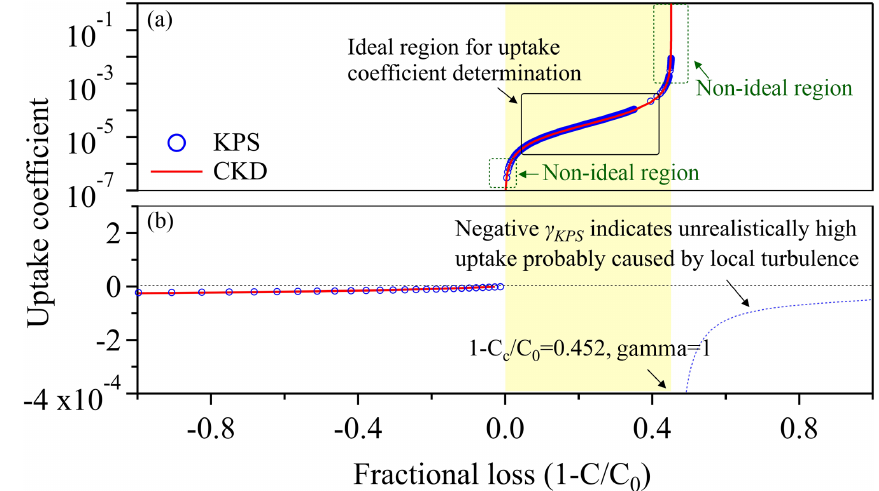
Figure C1. Comparisons between uptake coefficients (derived from KPS and CKD methods, respectively) versus the fractional loss. Panel (a) displays the derived positive uptake coefficients under the LF regime, and (b) the derived negative ones due to emission (left) or local turbulence effect (right). For derivation of this plot, the specific experimental configuration includes gas reactant, SO 2 ; carrier gas, synthetic air; volumetric flow rate F = 4Lmin − 1 at 1atm and 296K; flow tube dimension, d = 17mm, L =